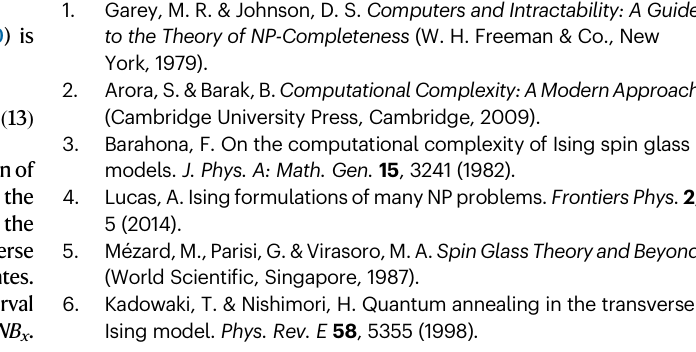
Fig.5|Exactdiagonalization. Low-energyspectraofEq.(3)fordifferent χ .System size is N =10. Red and orange straight lines are the reference and ground-state energies, correspondingly at χ =0. They are repeated on all panels as a guide for